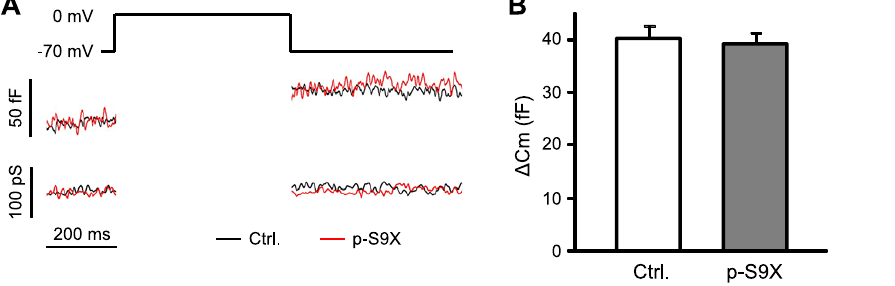
Figure 5. Normal membrane capacitance measurements in p-S9X mouse b -cells. ( A ) Membrane capacitance was recorded in functionally identified b -cells from p-S9X and control mice. Capacitance increase was elicited by 500 ms depolarizations from -70 to 0 mV. ( B ) Capacitance increases shown as means 6 SEM. N=7 for control mouse b -cells (white bar) and 9 for p-S9X (grey bar).